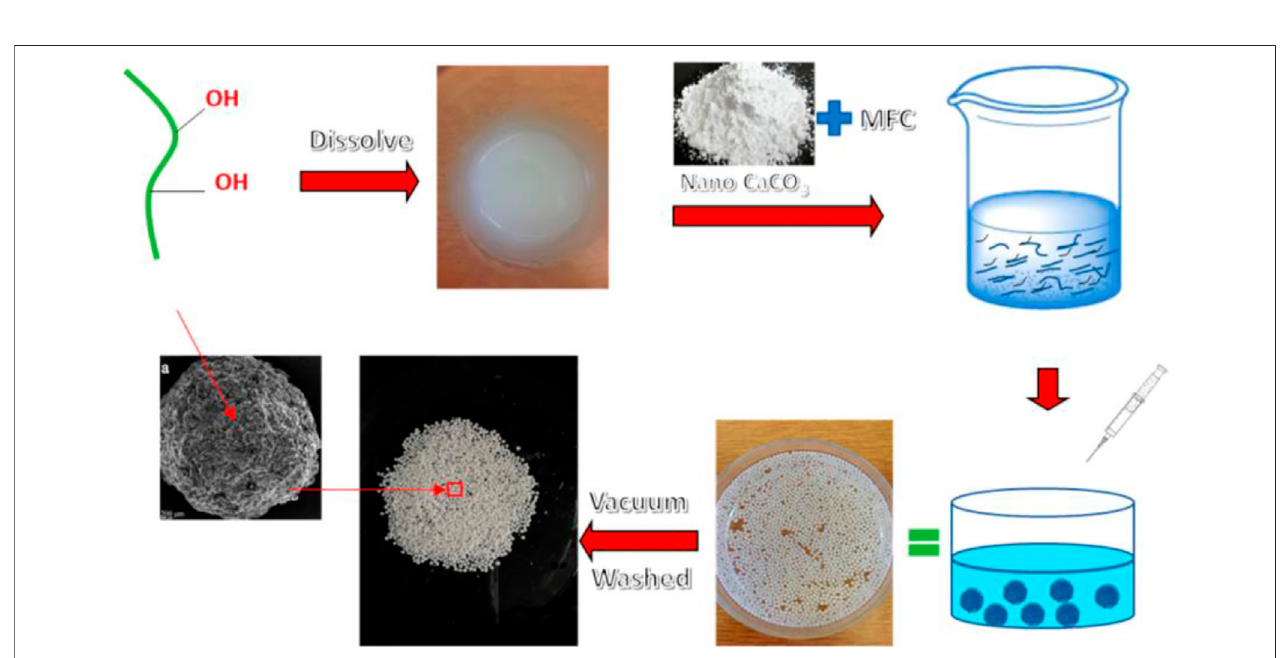
FIGURE8| SchematicrepresentationofMCMFCs.FigurereprintedwithpermissionfromRef.(Lietal.,2018).CopyrightbelongstotheAmericanChemicalSociety(ACS,2018).